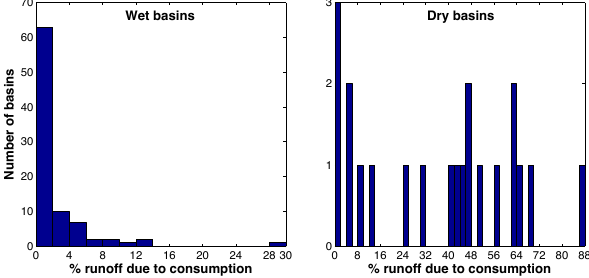
Fig. 2. The mean proportion of annual runoff (in %) due to con- sumption in wet and dry basins. 3